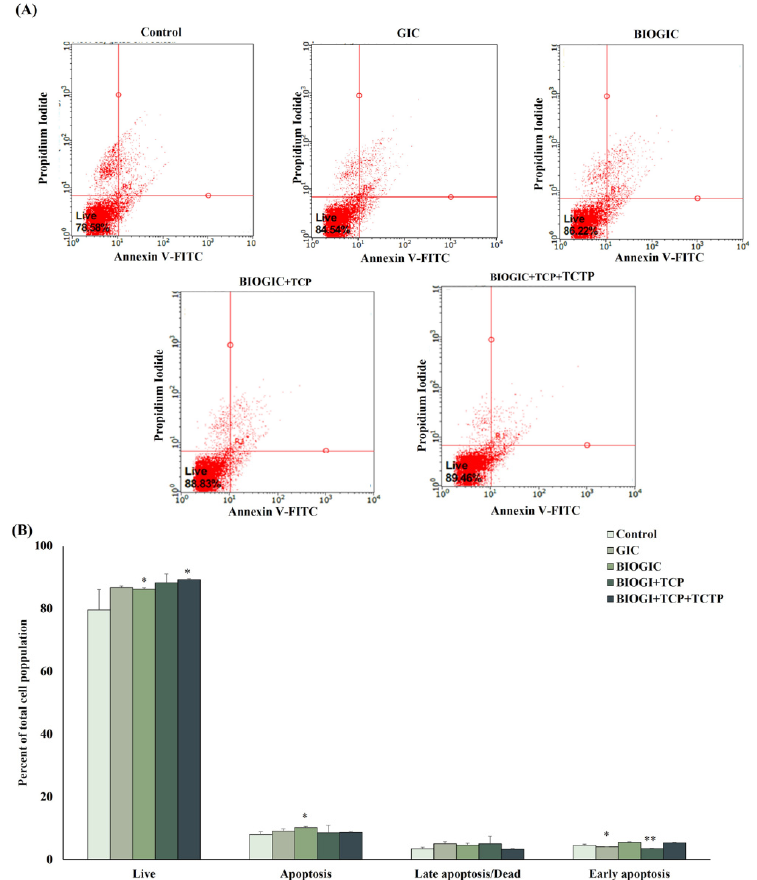
Figure 8. Anti-apoptotic property of TCTP against GIC. Cells were incubated with each group of specimens for 24 h. The apoptotic cells were determined by flow cytometry. ( A ) The flow cytometer images. ( B ) The percentage of total cell population. Data are represented as mean ± SD. Value significant difference at * p < 0.05 and ** p < 0.01 compared to control ( n = 4 in each group).